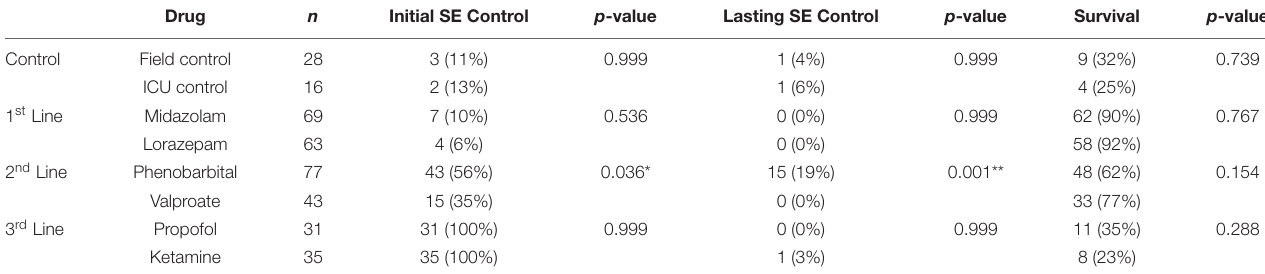
TABLE 1 | Outcomes for each therapeutic